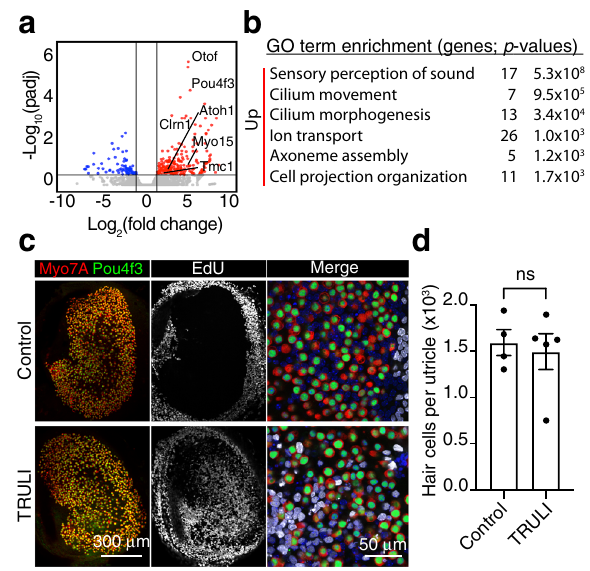
Fig. 5 Plasticity of utricular supporting cells after TRULI treatment. a A volcano plot visualizes the genes differentially expressed after 5 days of TRULI treatment of murine utricles followed by 5 days drug withdrawal (|log 2 (fold change)| > 1; padj < 0.05). The subset of hair-cell genes most upregulated after TRULI treatment compared to control is labeled. All the RNA-seq data are available through GEO (GSE148528). b Gene-ontology analysis performed with DAVID software demonstrates that terms associated with hair-cell differentiation and function are the most enriched in the genes upregulated by TRULI. c In representative examples of wholemount utricular explants after 5 days of TRULI treatment followed by 5 days drug withdrawal, immunolabeling for Pou4f3 (green) and Myo7a (red) depicts hair cells. New sensory receptors formed by proliferation of their precursors, supporting cells, are identi fi ed by EdU-incorporation (white) and are found only after TRULI treatment. Nuclei are labeled with DAPI. d The total number of hair cells per utricle does not change after TRULI treatment ( p = 0.7097 by a Student ’ s t -test; n = 4 for controls and n = 5 for TRULI-treated animals, mean ±